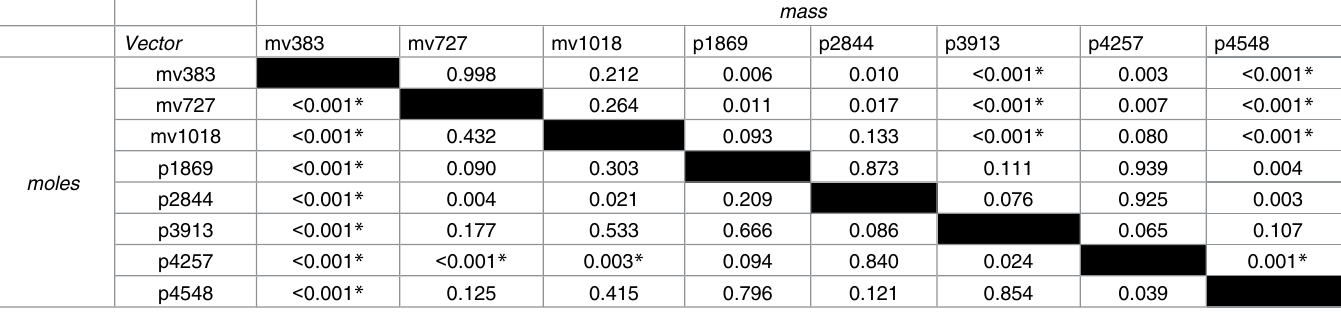
Table 1. Two-way ANOVA showing statistically significant effectsof vector size. P -values of pairwisecomparisonof vectors after taking mass (top) and moles (left) into account.